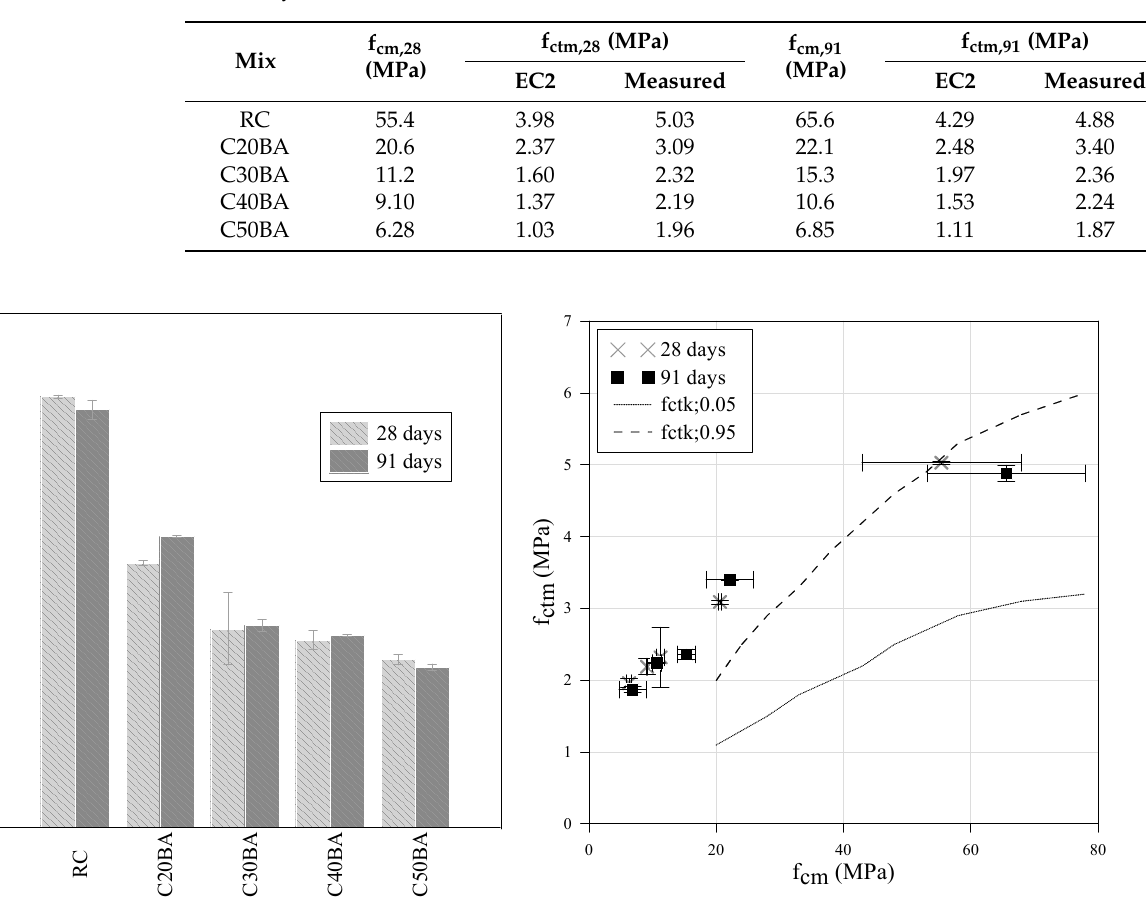
Table 6. Splitting tensile strength versus compressive strength determined according to EC2 at 28 and 91 days.